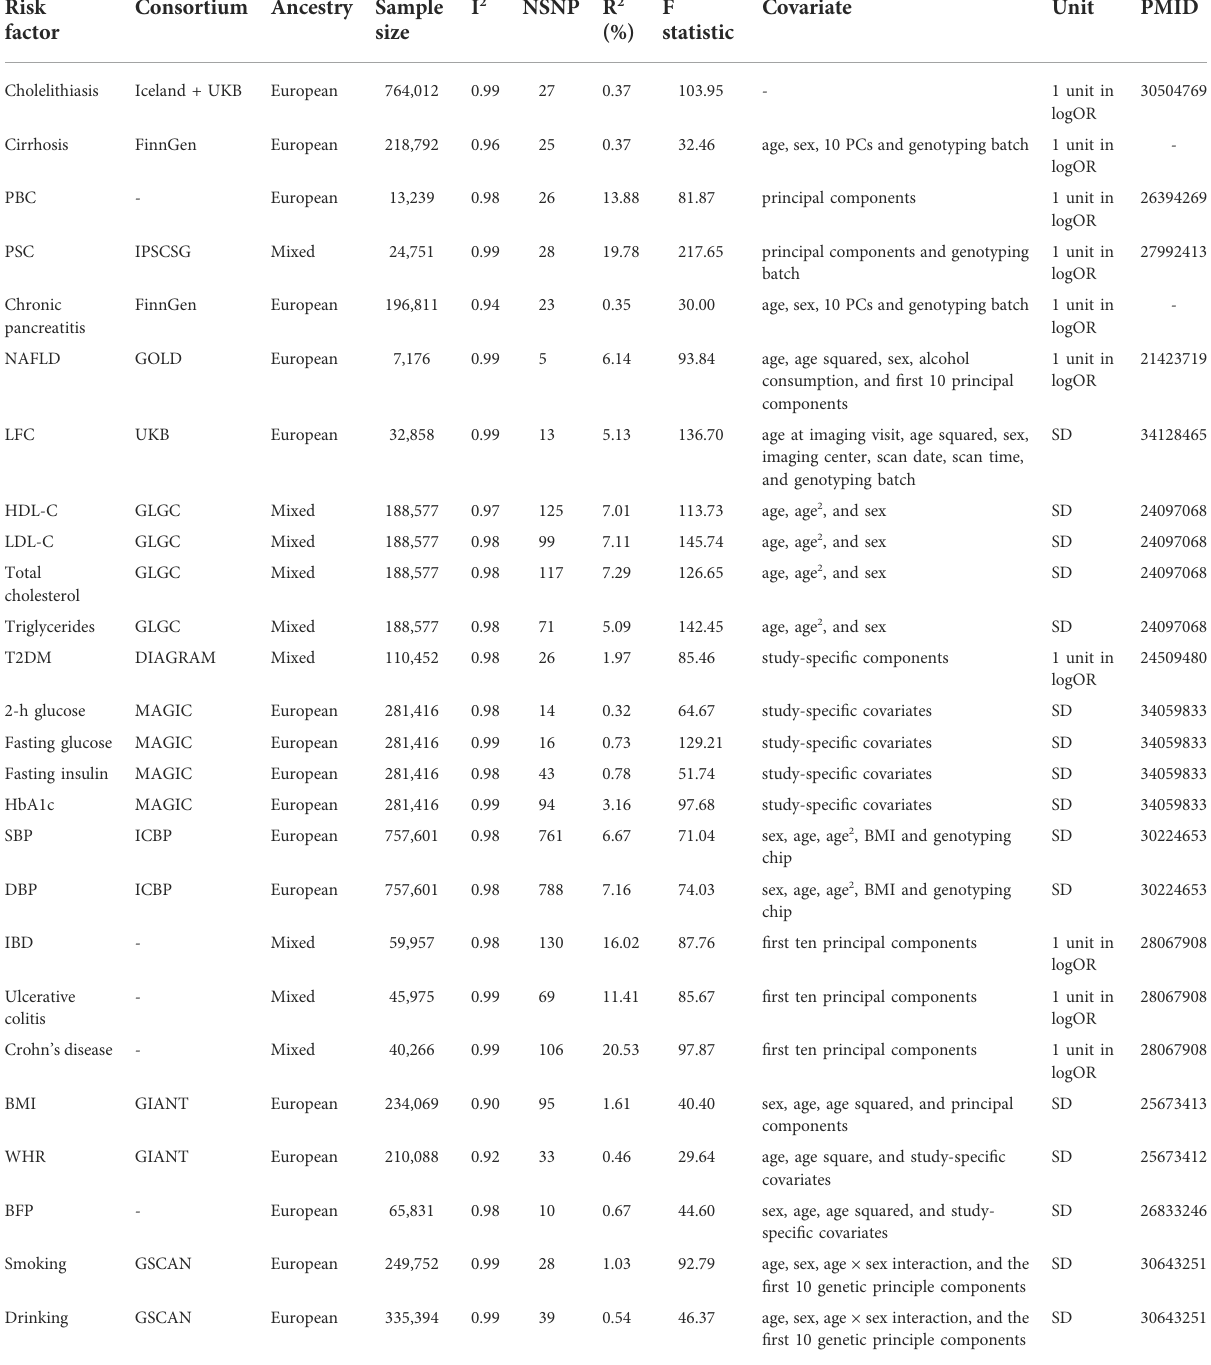
TABLE 1 Summarized GWAS information of each putative risk